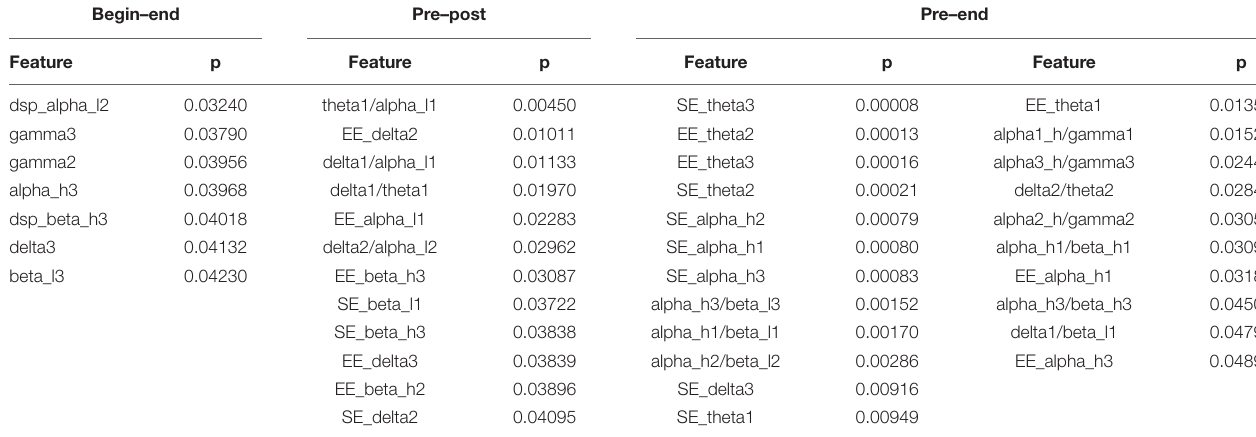
FIGURE 7 | Self-rating scale of normal participants. TABLE 4 | EEG features with significant